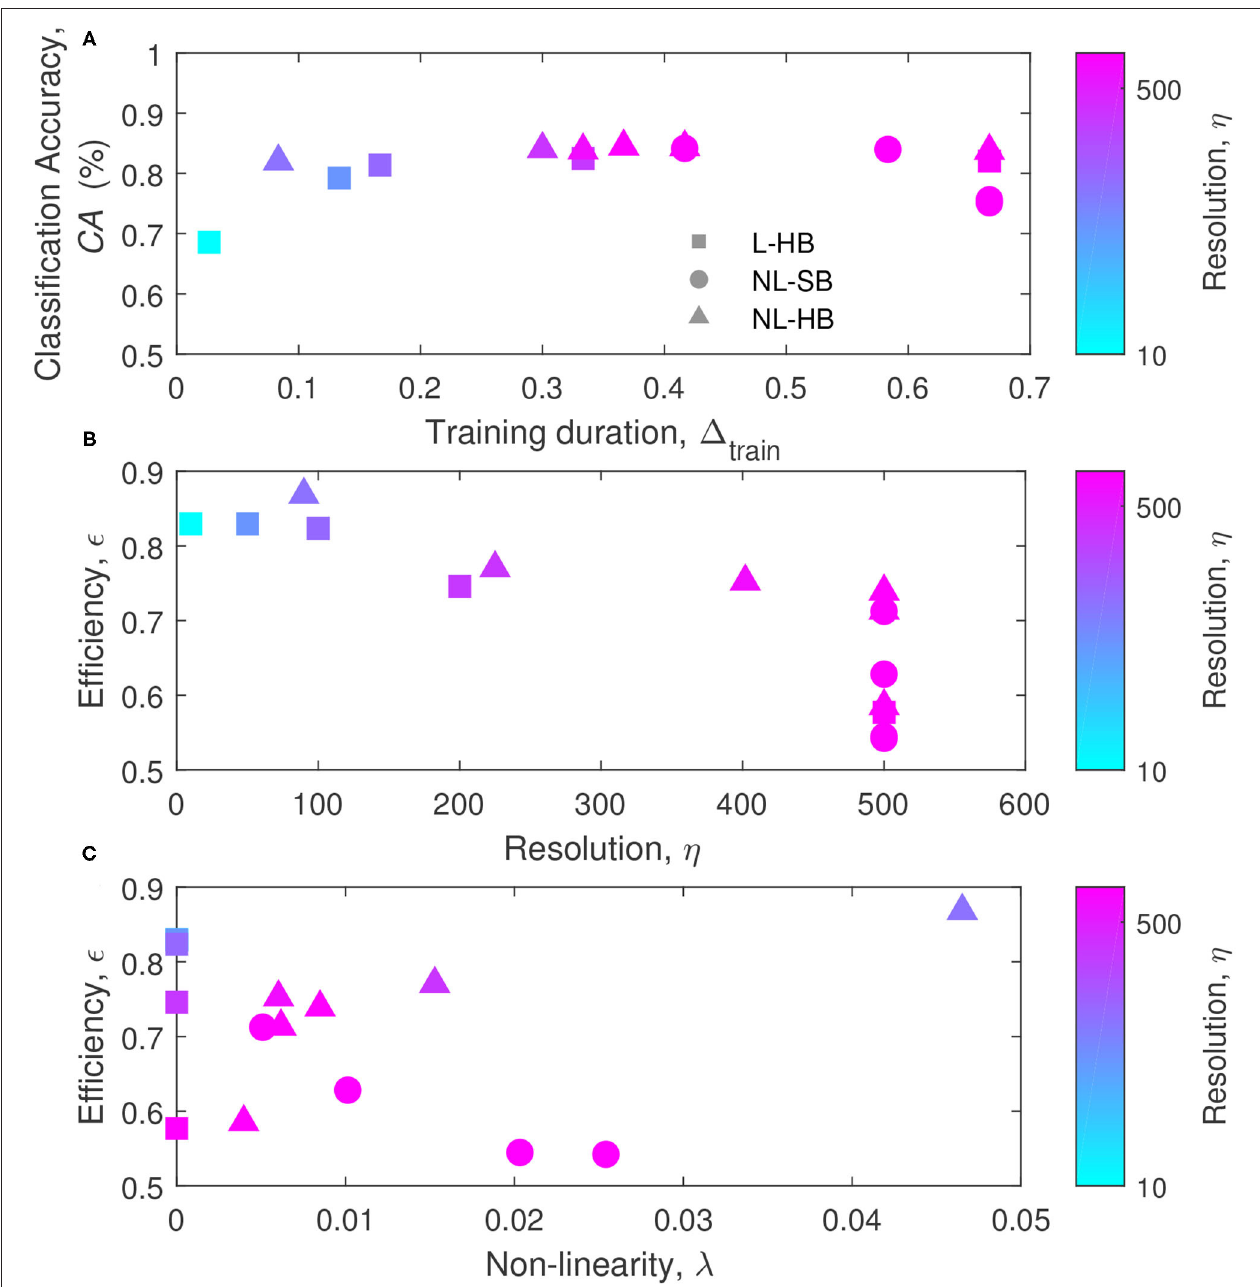
FIGURE 8 | (A) Classification accuracy, CA , as a function of the training duration, 1 train , for the various dynamics. (B) Efficiency as a function of the resolution, η , and (C) efficiency as a function of the non-linearity, λ . The symbols colors follow the resolution value, η , according to the color bars reported on the right sides of the